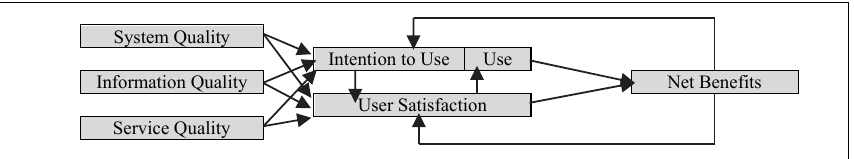
Fig. 1. DeLone and McLean (2003)